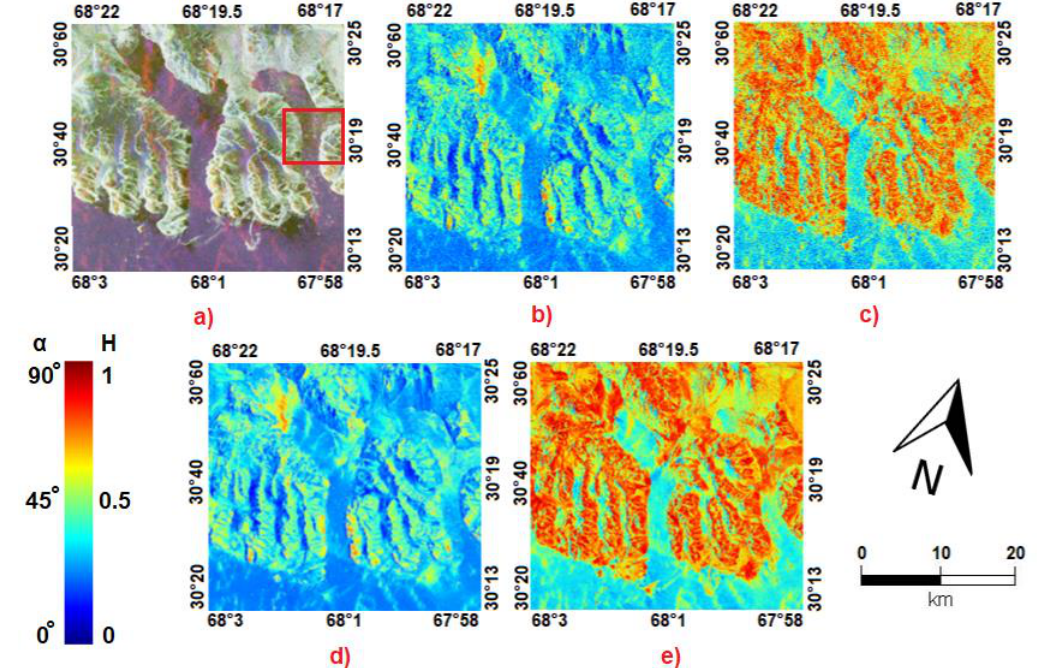
Figure 3. Output images for Blosseville Coast N, 15/08/2015 01:26, ( a ) Pauli RGB image, ( b ) alpha image in a 5 × 5 window, ( c ) entropy image in a 5 × 5 window, ( d ) alpha image in an 11 × 11 window, ( e ) entropy image in an 11 × 11 window. Red box indicates extent of Figure 4. Numbers on the edges of images indicate image DMS coordinates. The sea ice situation is a mix of ice floes and open ocean.